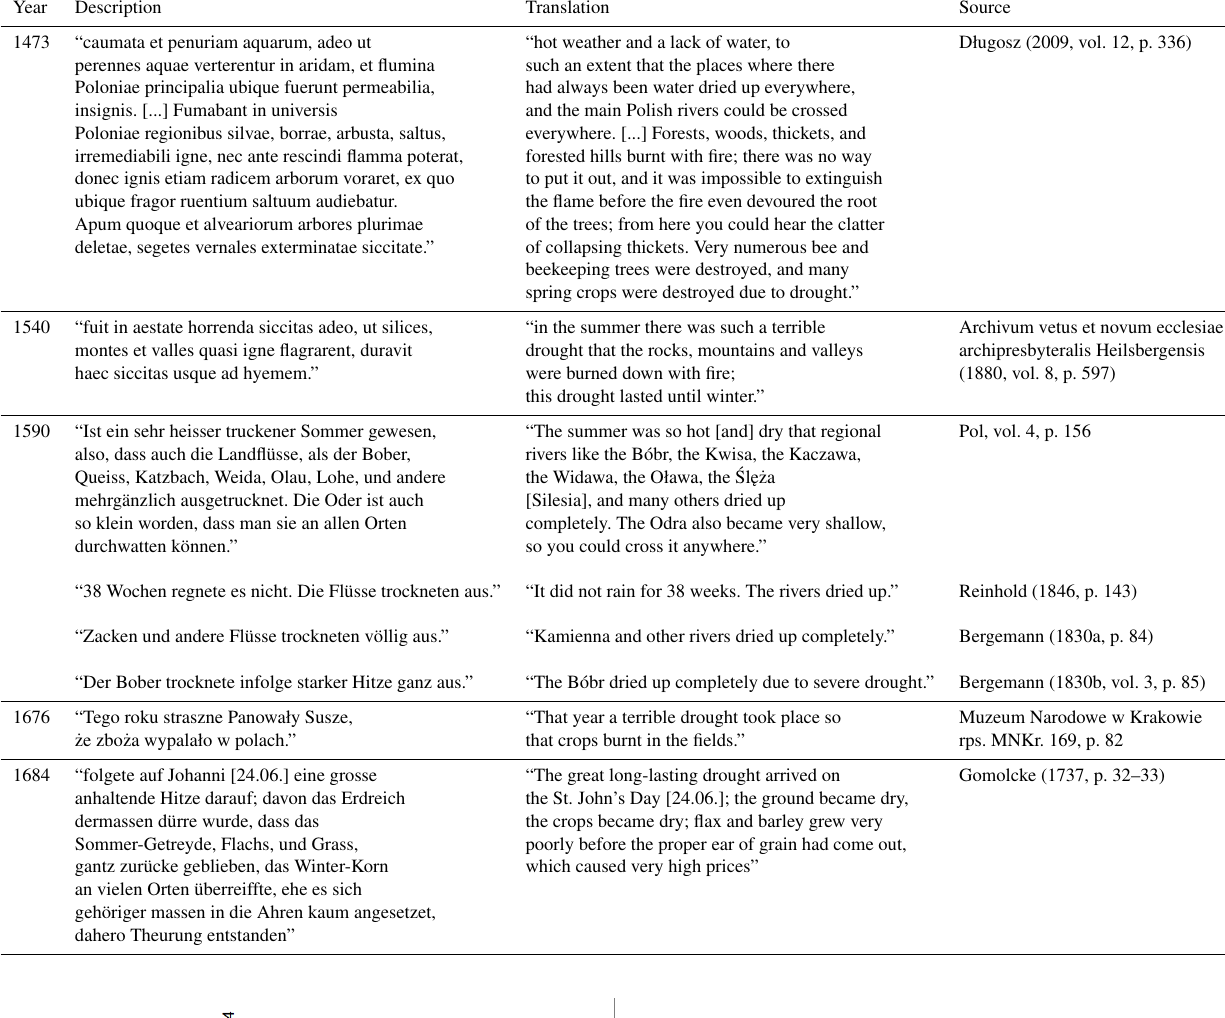
Table 3. Examples of descriptions of extreme droughts (megadroughts) in 15th–17th-century sources.